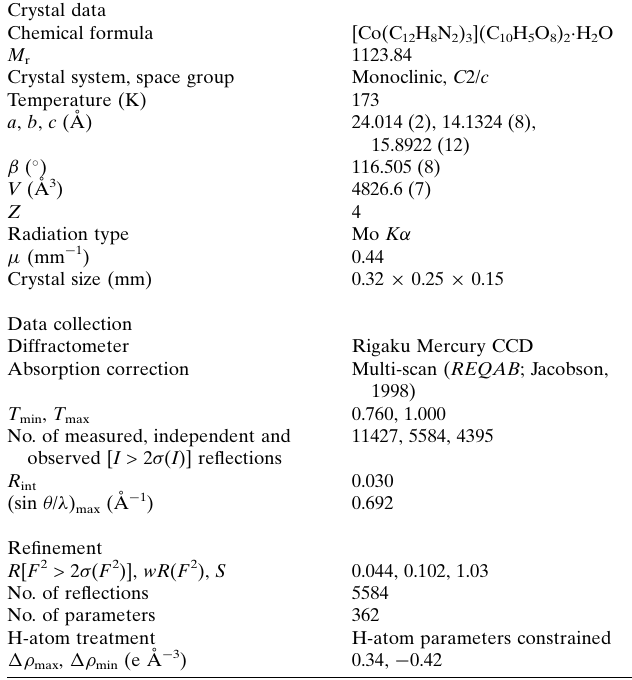
Table 3 Experimental details. Crystal data Chemical formula